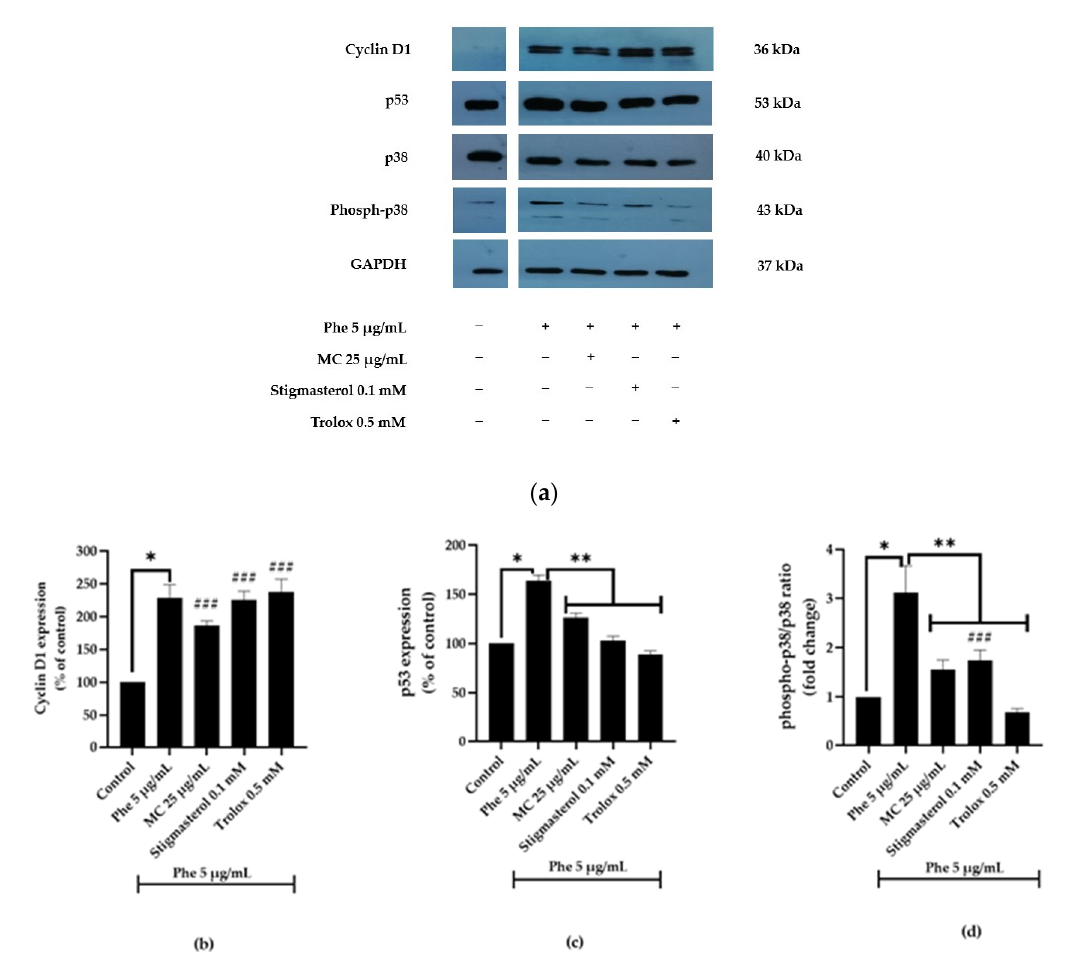
Figure 6. Representative blots showing Cyclin D1, p53, p38, and phospho-p38 expression ( a ). Normalized values of Cyclin D1 ( b ), p53 ( c ), and p38 and phospho-p38 ( d ) against GAPDH. * p < 0.05 vs. control; ** p < 0.05 vs. 5 µ g/mL Phe alone. For Cyclin D1, * p = 0.002. For p53, * p = 0.002; ** p = 0.024, 0.003, and 0.001. For phospho-p38/p38 ratio, * p = 0.000; ** p = 0.000, 0.001, and 0.000, respectively. For p53 expression, there was no significant difference in all MC-, stigmasterol-, and trolox- treated groups compared with control groups. For cyclin D1 expression, ### p value was 0.007, 0.003, and 0.001 in Phe group combined with 25 μ g/mL MC, 0.1 mM stigmasterol, and 0.5 mM trolox, respectively, compared with control group. For phospho-p38/p38 ratio, ### p value was 0.046 in Phe group combined with 0.1 mM stigmasterol compared with control group ( n = 3).